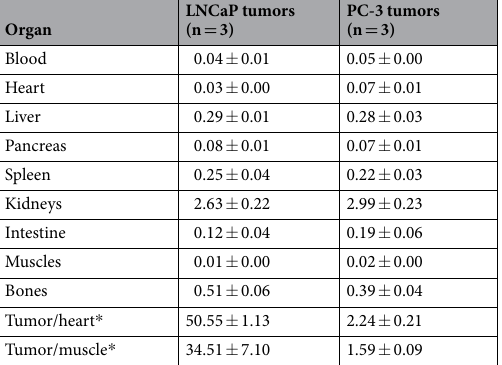
Table 2. Uptake of 177 Lu-scFvD2B in nude male mice bearing LNCaP or PC-3 pulmonary microtumors at 192 h post-injection. Values are %ID/g, expressed as mean ± SD. * Tumor-to-organ ratios were calculated from the SUVs obtained at 192